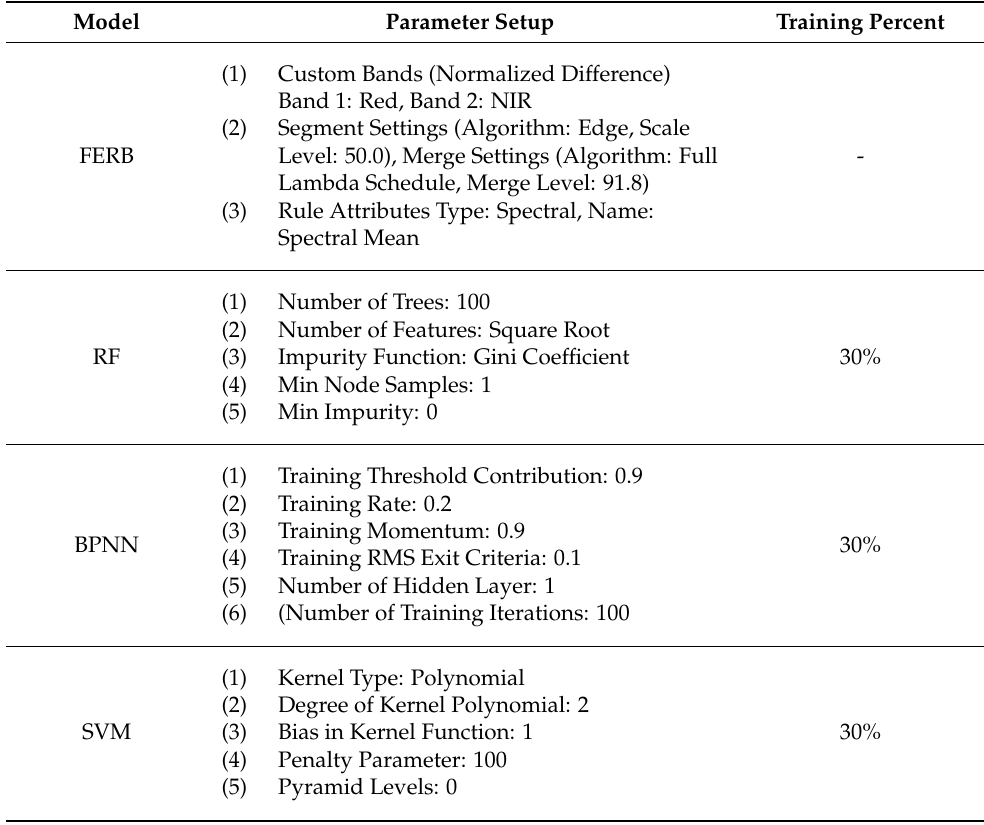
Table 4. Parameter setup of FERB, RF, BPNN, and